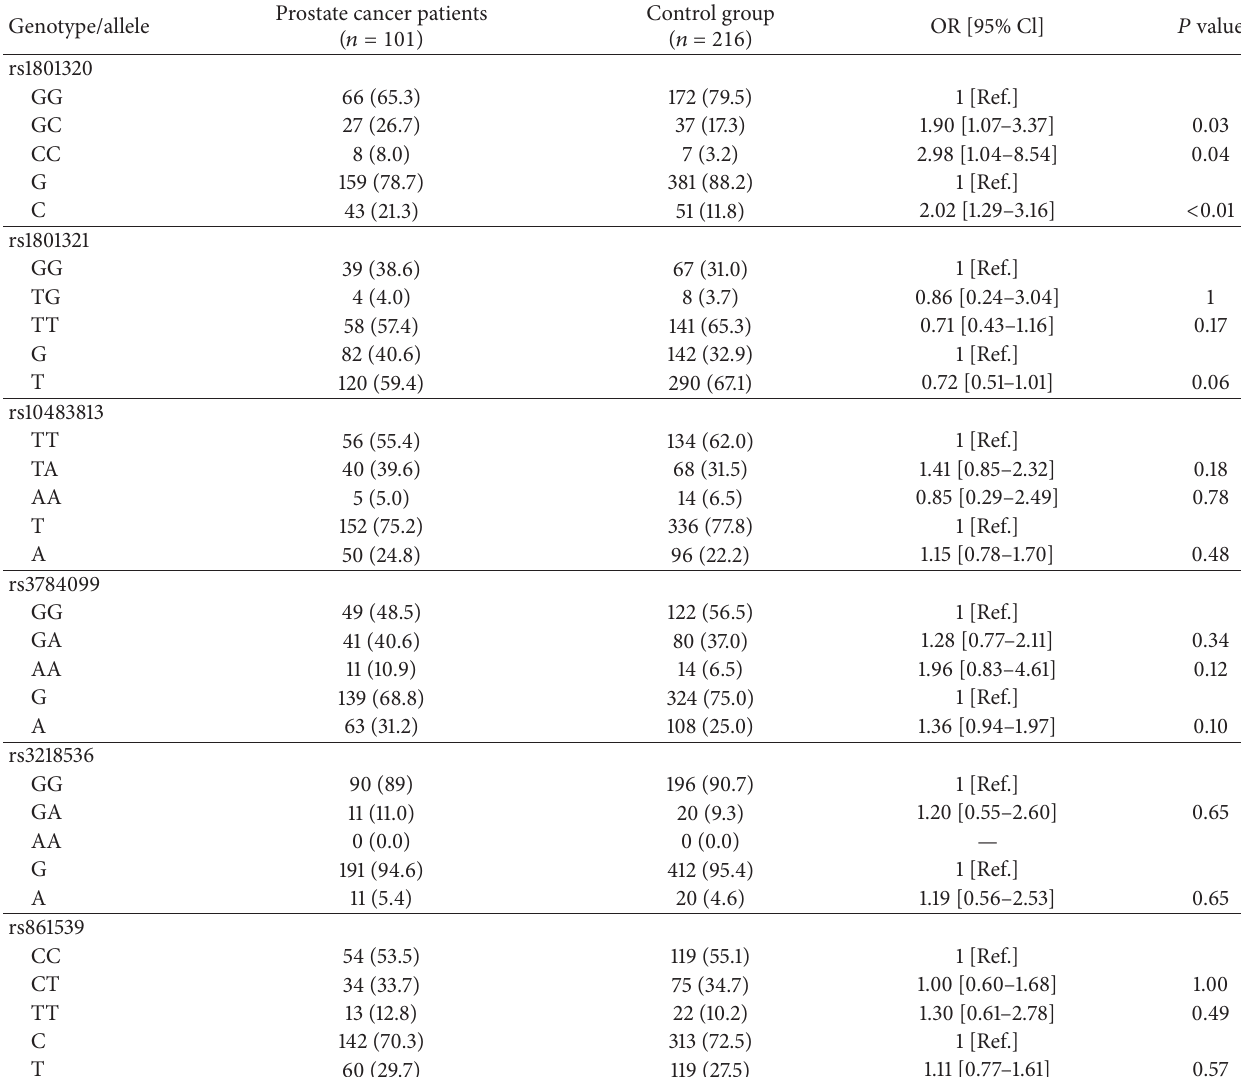
Table 5: Genotype distribution and prostate cancer risk for the RAD51 , RAD51B , XRCC2 , and XRCC3 polymorphisms in prostate cancer patients and control group.